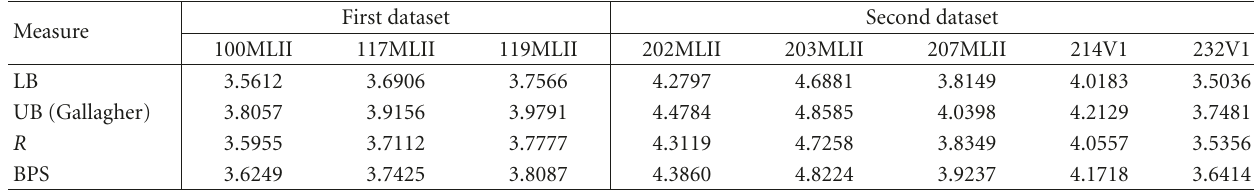
Table 3: ABT method: comparison between the theoretical bounds and the results obtained using Hu ff man encoder. Measure